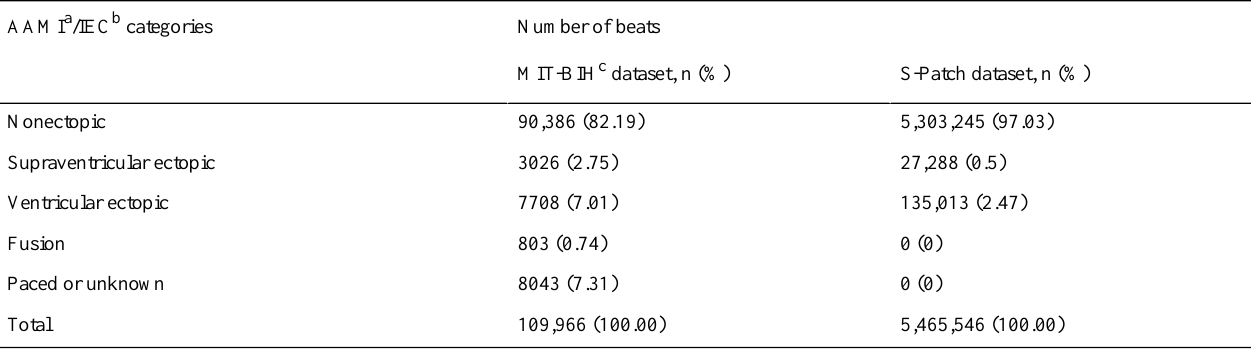
Table 1. The five subtype classes and the number of